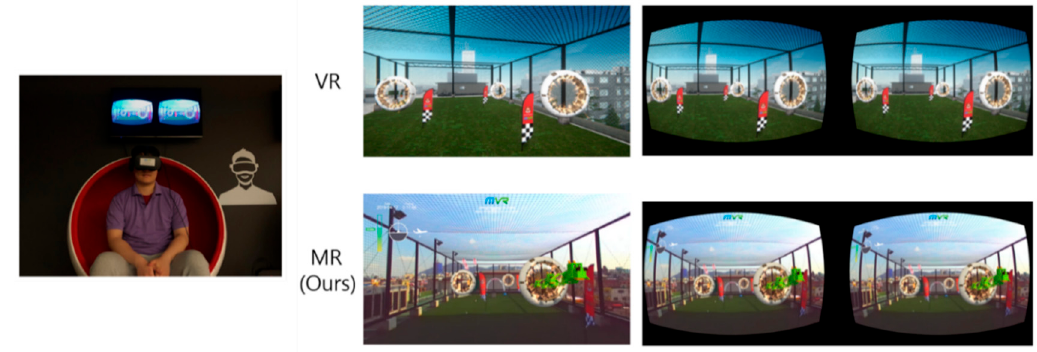
Figure 9. A participant viewing FPV flying scenes in virtual reality (VR) and MR